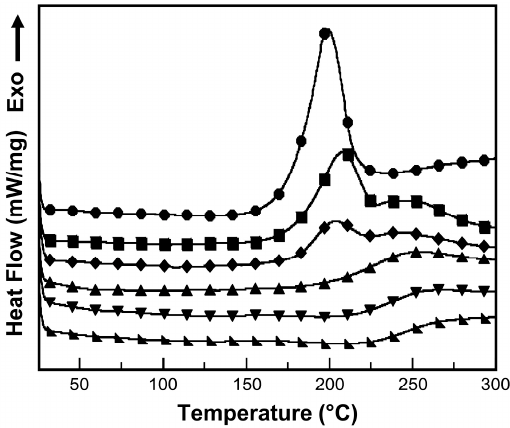
Figure 5. DSC thermograms of ( ● ) pure V-fa and V-fa/ECO binary mixture at 50 wt% of V-fa content after a step thermal curing: ( ■ ) uncured binary mixture, ( ♦ ) 150 °C/1 h, ( ▲ ) 160 °C/1 h, ( ▼ ) 170 °C/2 h, and ( ◣ ) 180 °C/2 h.